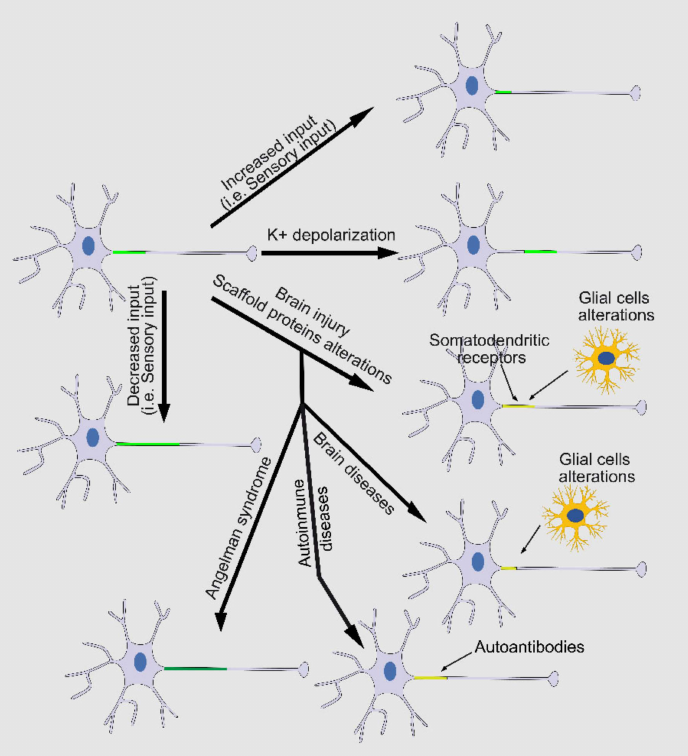
Figure 2. Axon initial segment plasticity in response to intrinsic and extrinsic factors. The AIS